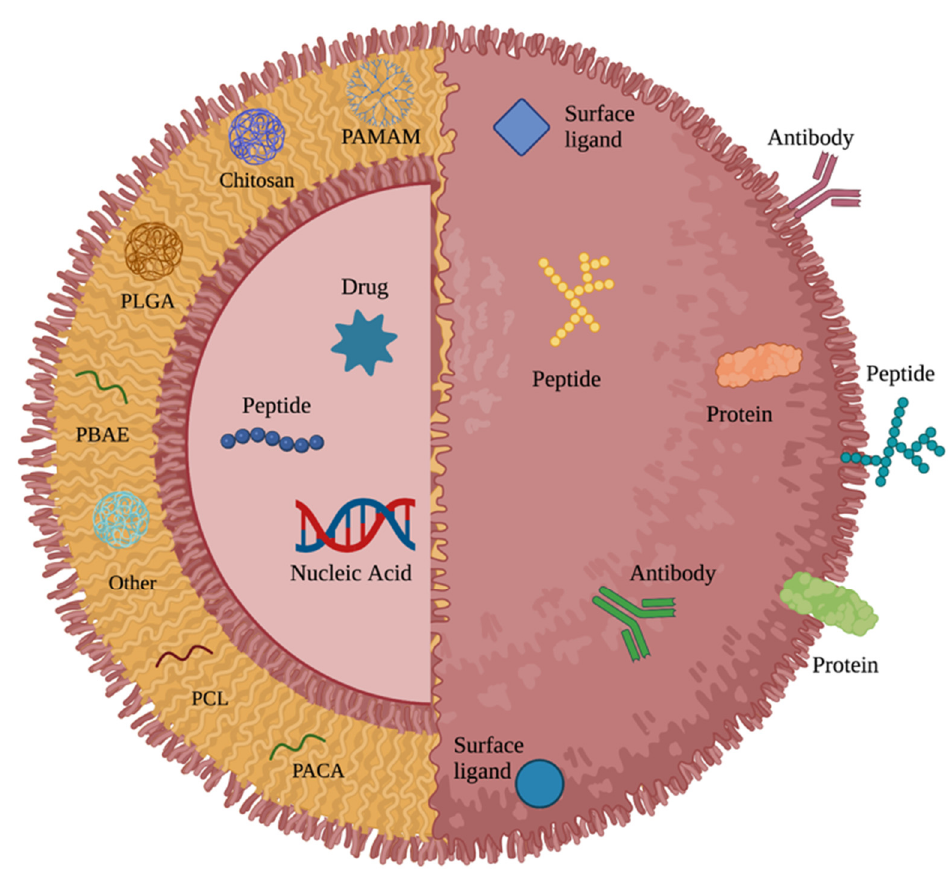
Figure 1. General structure of a polymeric nanoparticle.